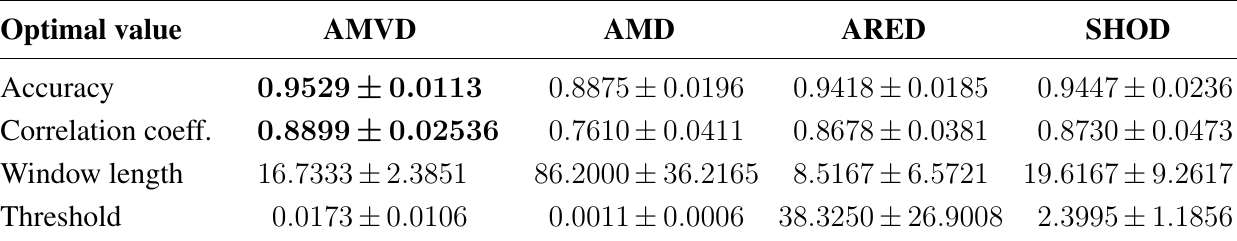
Table 7. Algorithms applied to real signals. Average Accuracy, Correlation coefficient and associated parameters (Magnitude methods without flexible input).